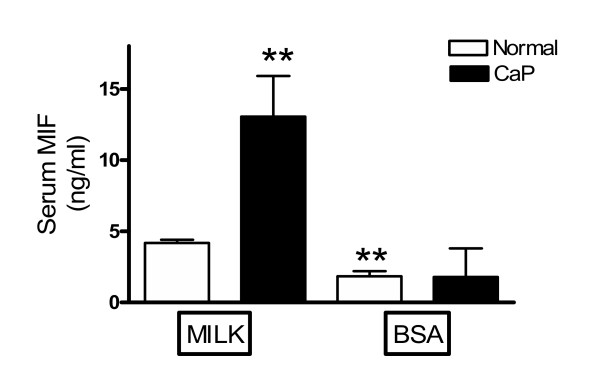
Comparison of Serum MIF amounts determined by different ELISA conditions. A subset of random serum samples were from pulled from our serum bank from patients with no documented diagnosis of prostate cancer (n = 5) and from patients with CaP (n = 5). The serum MIF amounts were determined in parallel using either a milk based serum blocking/diluent solution or phosphate buffered saline pH 7.4 with 1% bovine serum albumin. Data are expressed as median ± interquartile range, ** = p < 0.01, when compared to Milk normal serum samples.